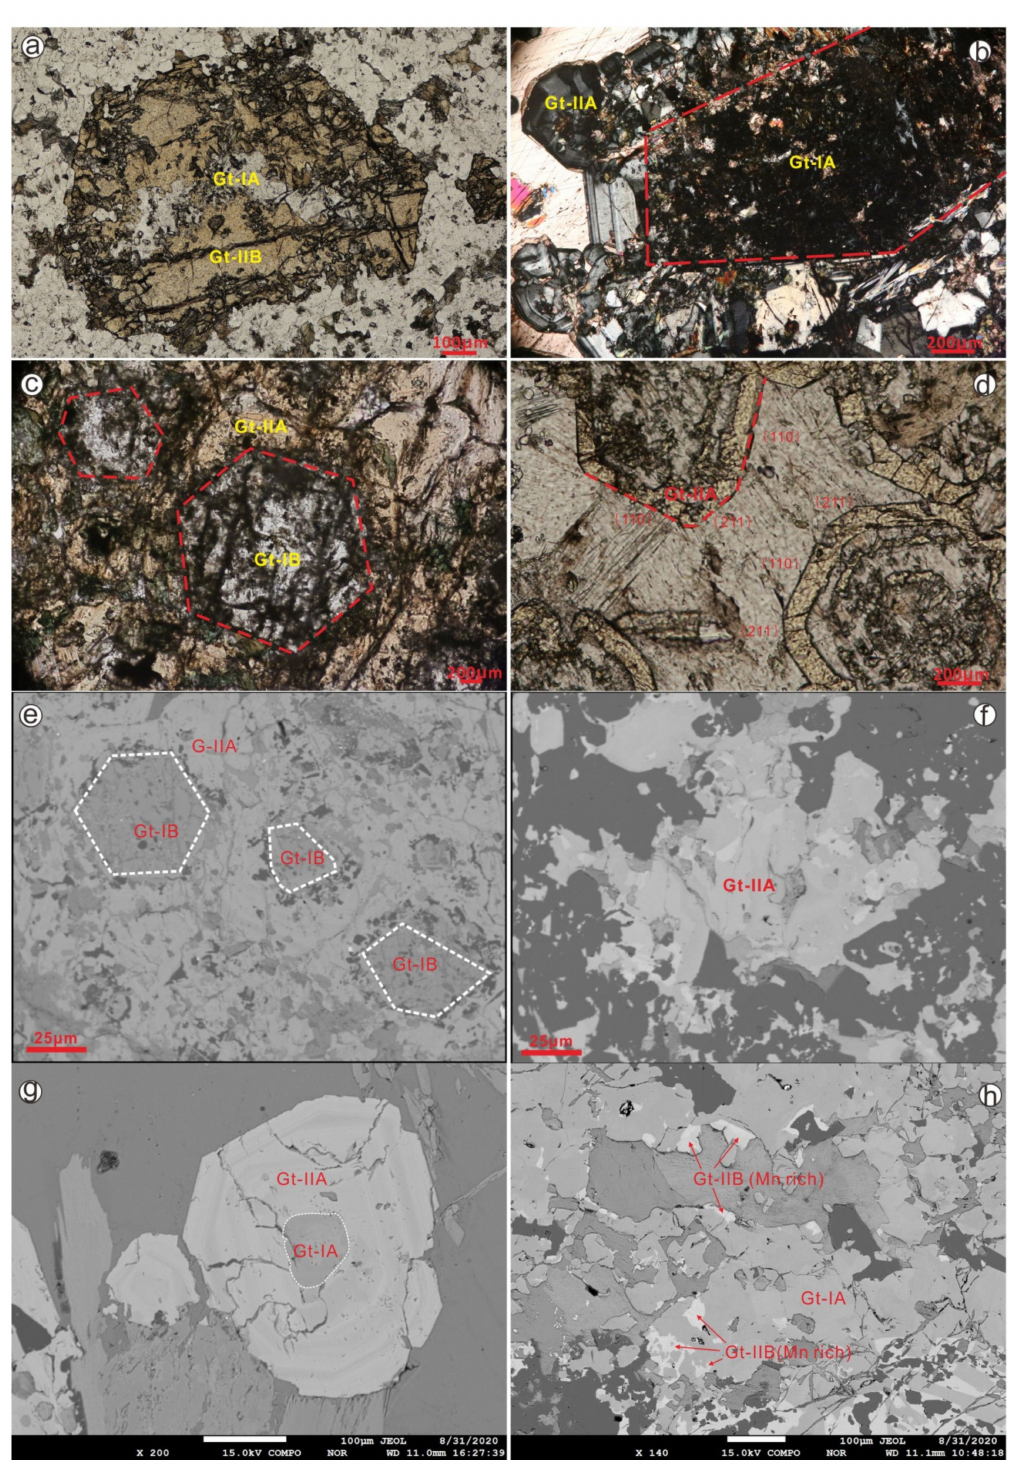
Figure 4. Microscopic and BSE (back scattered electron) characteristics of four types of garnet from the Zhuxiling W (Mo) deposit. ( a ) Pale white Gt-IA garnet is irregularly replaced by beige Gt-IIB garnet; ( b ) Gt-IA is isotropic and shows complete extinction, whereas Gt-IIA garnet is anisotropic with oscillatory zoning; ( c ) spotted euhedral Gt-IB garnet crystal encircled by beige Gt-IIA garnet; ( d ) development of trapezohedron {211} faces in Gt-IIA garnets on pre-existing dodecahedral {110} garnets; ( e ) BSE imaging of euhedral Gt-IB garnet, which is darker than surrounding Gt-IIA garnets; ( f ) patched BSE imaging for typical Gt-IIA garnet; ( g ) BSE image illustrating one euhedral garnet crystal with dark and irregular Gt-IA garnet in the core and oscillatory zoned Gt-IIA garnet in the rim. ( h ) Presence of Mn-rich (spessartine dominate) garnet at the margin of the Gt-IA